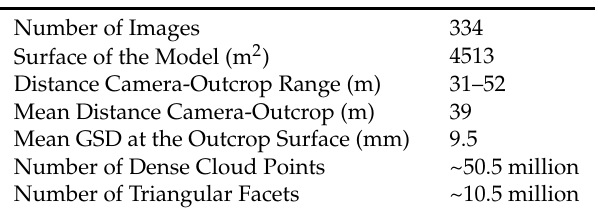
Table 2. Characteristics of